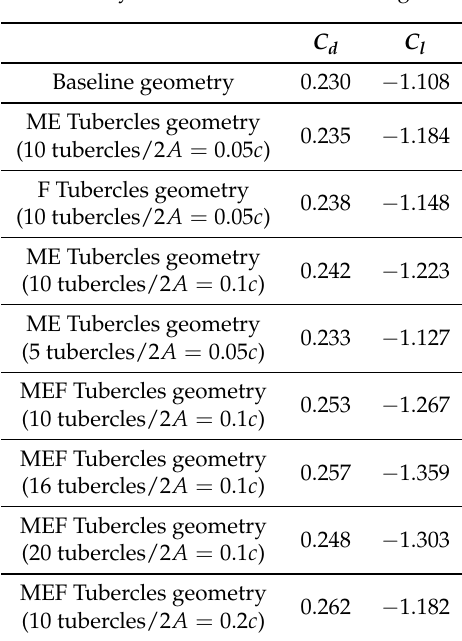
Figure 9. Aerodynamic coefficients comparison between each geometry. Table 6. Aerodynamic coefficients for each